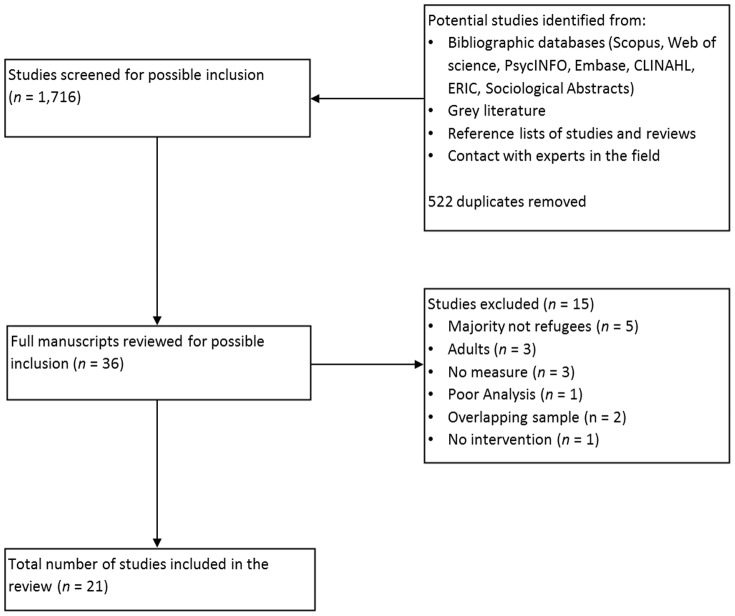
Flow Diagram to show the process of Study Selection.